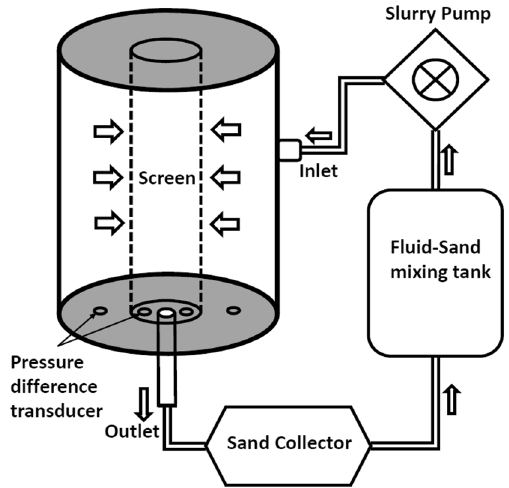
Fig. 5 Schematic diagram of the full-screen test apparatus which can replace the screen test chamber in Fig. 2. Modified after Changyin et al.